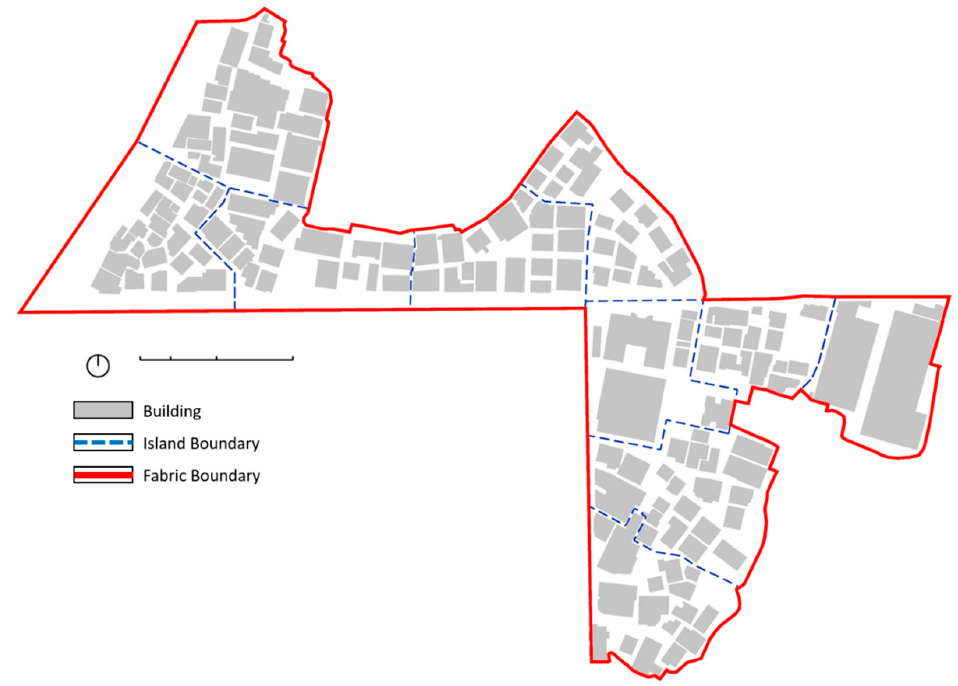
Figure 6. Boundaries of islands and fabric.